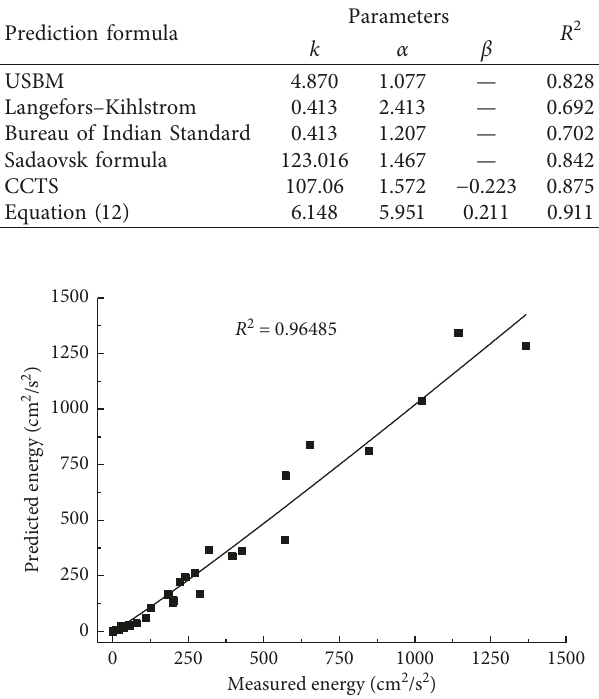
Figure 10: Measured energy against predicted energy fitted by energy prediction